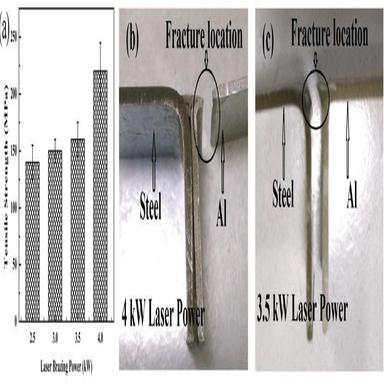
(a) Tensile strength of the laser brazed joints with different powers, (b) fracture location at aluminum side (4 kW power), (c) fracture location at the interface (3.5 kW power).